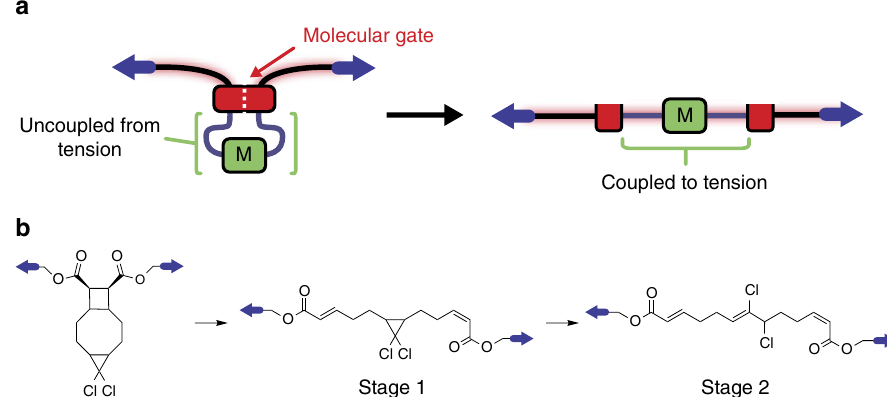
Figure 1 | Schematic representation and molecular design of mechanical reaction gating. ( a ) A molecular gate (red block) prevents a protected mechanophore substrate (green) from feeling force. Applying sufficiently high force to the gate unlocks it mechanically, allowing the force to be transmitted to the substrate. ( b ) A cyclobutane mechanophore functions as the gate, and its mechanical cycloreversion unlocks the system so that initially protected cis - gem -dichlorocyclopropane ( cis-g DCC) is